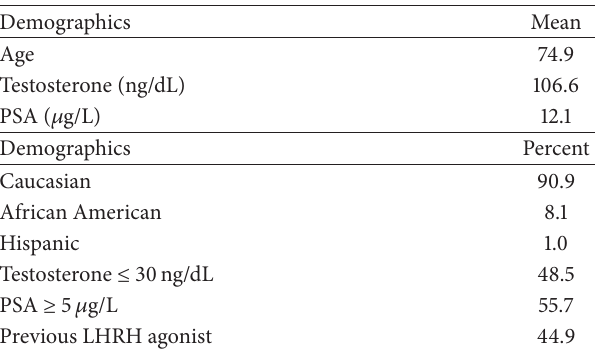
Table 1: Summary of baseline demographics.